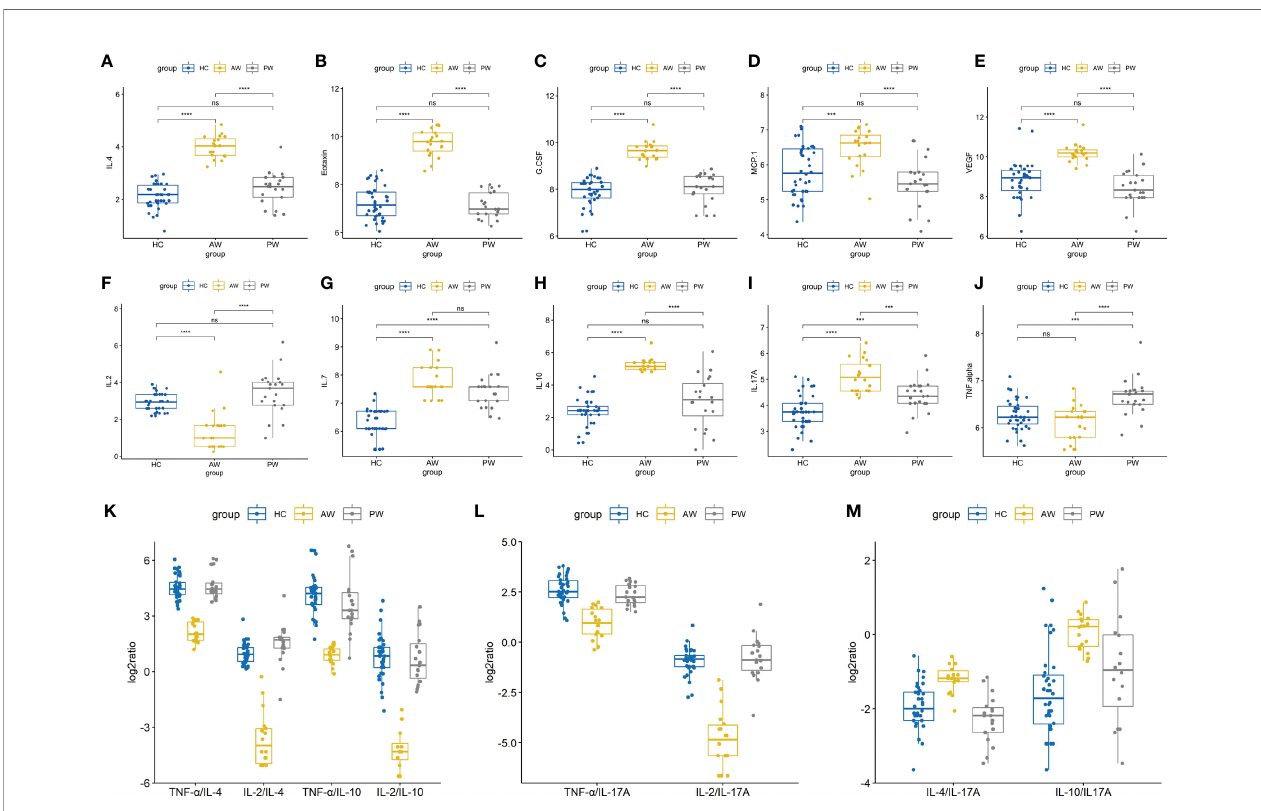
FIGURE 1 | Alterations in cytokine pro fi les in heroin addicts during withdrawal. (A – J) The levels of various cytokines in the plasma samples of healthy controls, heroin addicts from AW and PW groups was investigated, including IL-4 (A) , Eotaxin (B) , G-CSF (C) , MCP-1 (D) , VEGF (E) , IL-2 (F) , IL-7 (G) , IL-10 (H) , IL-17A (I) , TNF- a (J) . (K – M) Th1/Th2/Th17/Treg balance in heroin addicts across two withdrawal stages (AW and PW). The ratio of T h 1/T h 2, T h 1/T reg (K) and T h 1/T h 17 (L) was signi fi cantly decreased in AW stage, and recovered in PW stage. The ratio of T h 2/T h 17 and T reg /T h 17 (M) was signi fi cantly increased in AW stage, and recovered in PW stage. Each dot represents one patient in each group. Values of all signi fi cant correlations (p < 0.05) are given with degree of signi fi cance indicated (*p < 0.05, **p < 0.01, ***p < 0.001 and ****p < 0.0001). All intergroup comparisons by Mann-Whitney U-test.